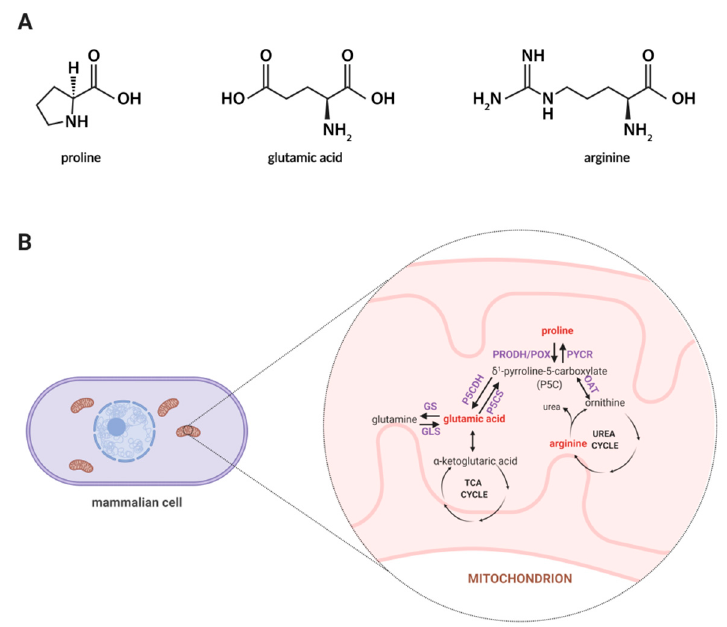
Figure 1. ( A ) Structures of proline, glutamic acid and arginine. ( B ) Proline metabolism in mammals. The proline metabolism involves the metabolism of other amino acids, such as ornithine, arginine, glutamic acid, and glutamine, and is related to the urea cycle and TCA cycle. Metabolites covered by the developed methodology are marked in red color. Abbreviations: GDH, glutamate dehydrogenase; GLS, glutaminase; GS, glutamine synthase; OAT, ornithine aminotransferase; PRODH/POX, proline dehydrogenase/oxidase; PYCR, P5C reductase; P5CDH, P5C dehydrogenase; P5CS, P5C synthase; TCA, tricarboxylic acid. Created with BioRender.com.